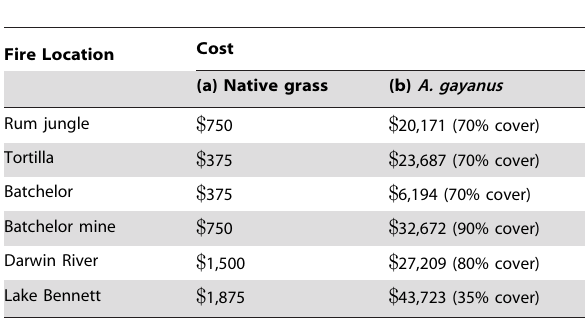
Table 6. Comparison of costs (in 2010 dollar values) from six paired fires in (a) native grass, (prior to A. gayanus grass invasion) and (b) A. gayanus fuelled